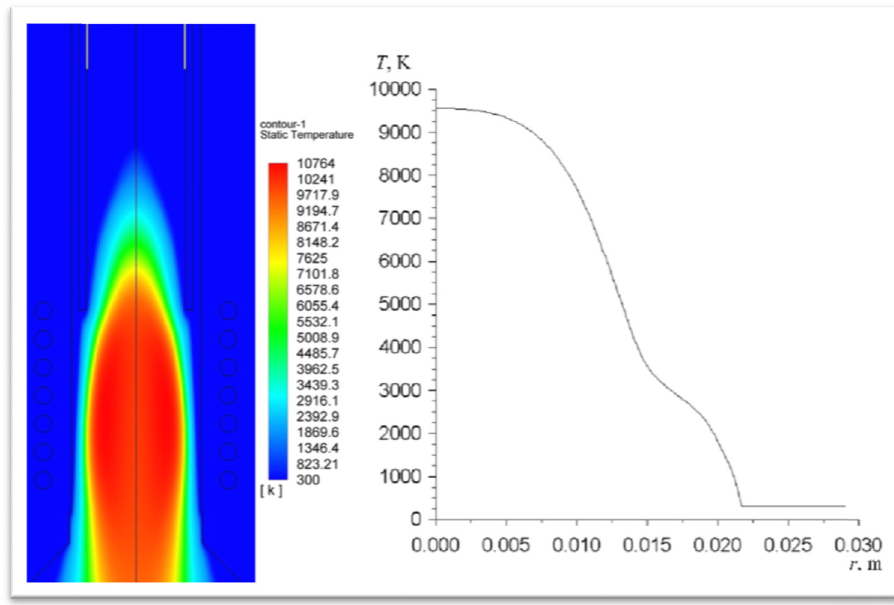
Figure 3: Calculated plasma temperature fi eld and plasma temperature distribution in the output section of a 15 kW plasma torch and a hydrogen – argon mixture ( 1:10 )